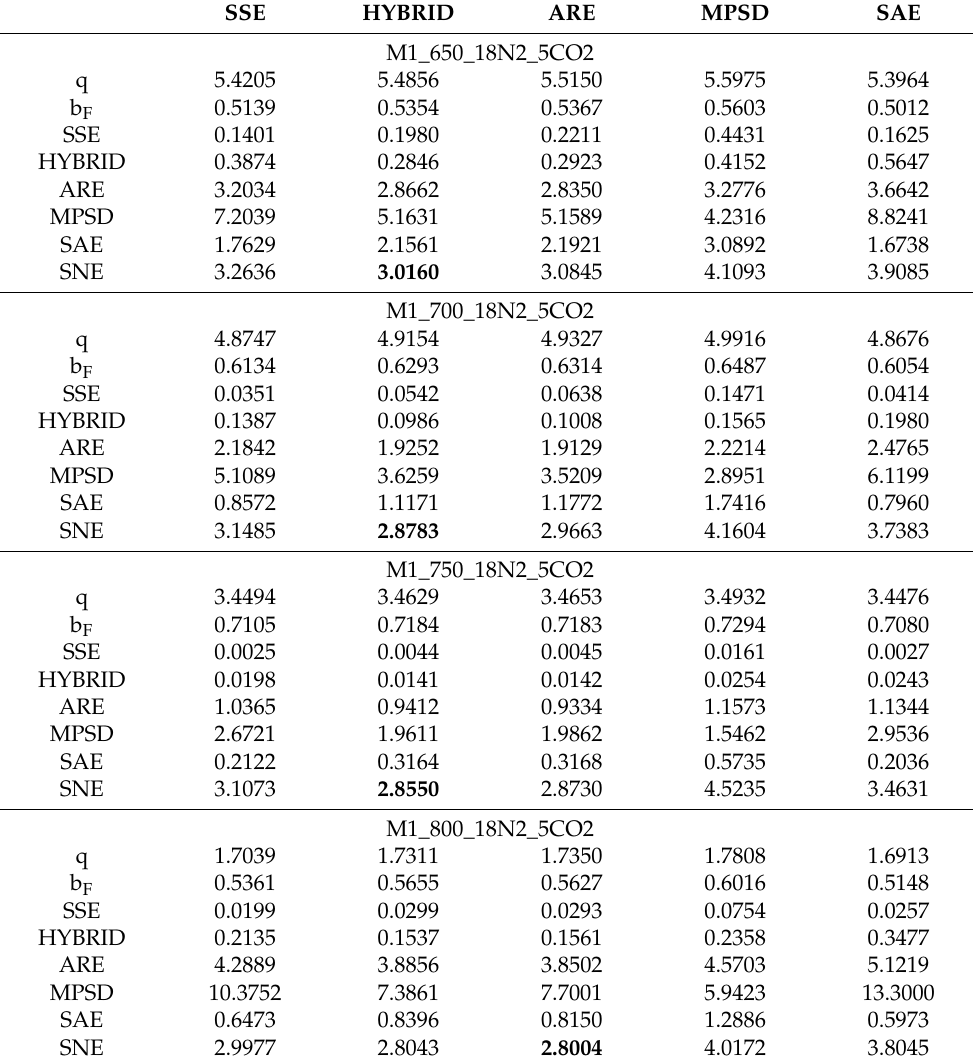
Table 4. Freundlich isotherms constants with error analysis *.